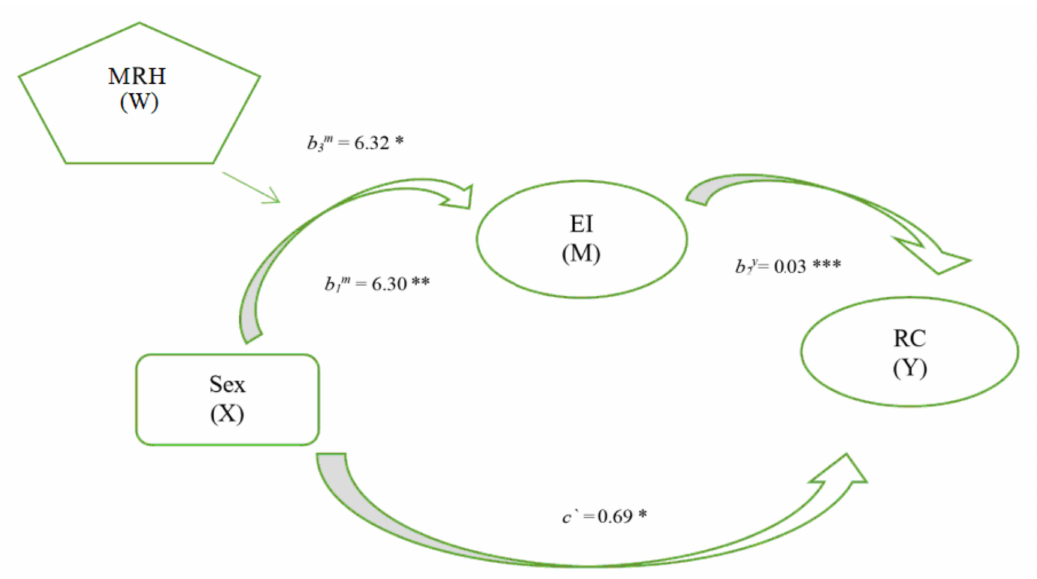
Figure 1. Moderated Mediation Model. Note. * p < 0.05; ** p < 0.01; *** p < 0.001. X = Independent variable, M = Mediating variable, W = Moderating variable, Y = Dependent variable, EI = Emotional Intelligence.